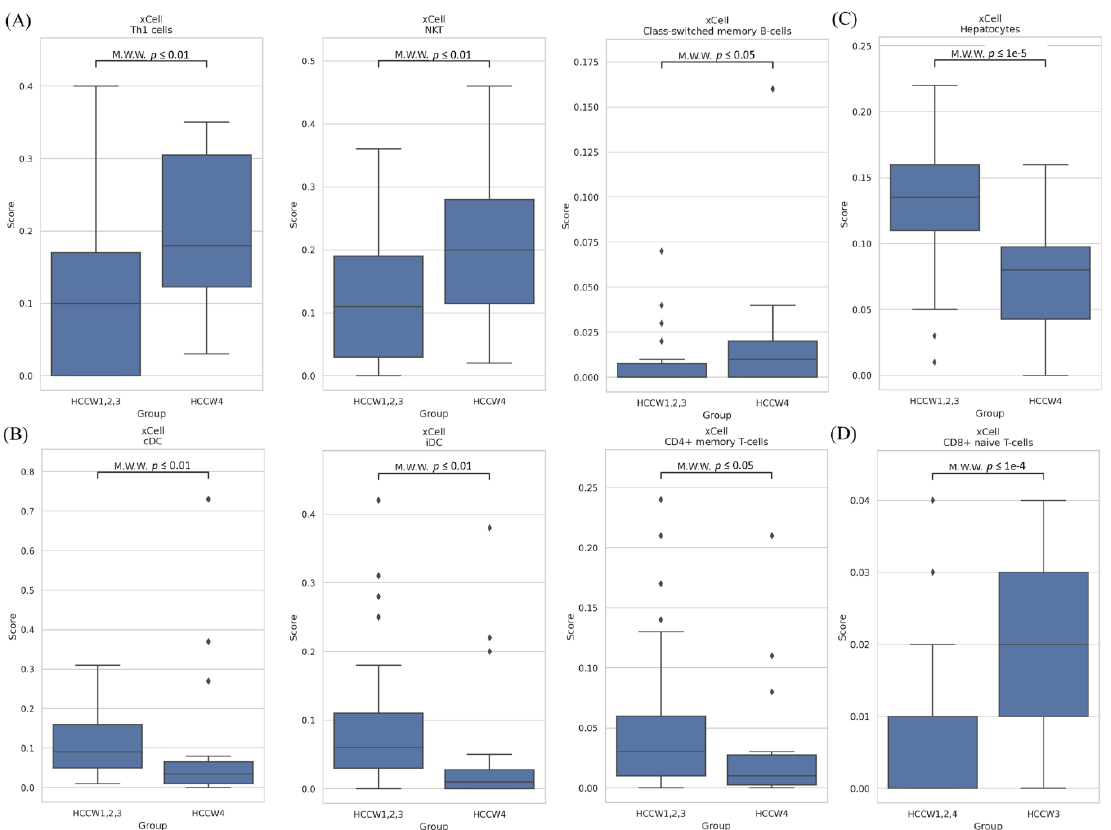
Figure 7. Immune characteristics of HCC subclasses. ( A , B ) Boxplots of immune cells differing between the subgroup with the worst prognosis (HCCW4) and the other subgroups. ( C ) Boxplot of hepatocytes differing between the subgroup with the worst prognosis (HCCW4) and the other subgroups. ( D ) Boxplots of immune cells differing between the subgroup with the best prognosis (HCCW3) and the other subgroups. The statistical difference was compared through the Mann– Whitney U test, and the p -values were shown above each boxplot.